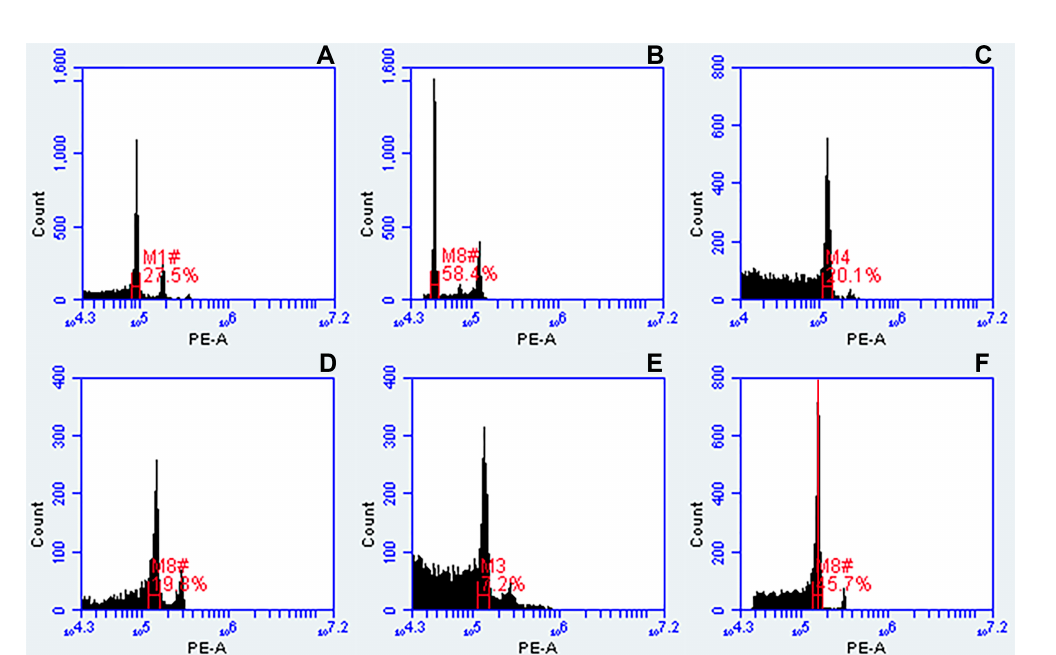
Figure 2. Optimization of flow cytometry assay for dried leaf samples. ( A ) Three gradually declined peaks of diploid U. decumbens CIAT 26185 indicating endoreduplication; ( B ) additional high peak in histogram of tetraploid U. maxima CIAT 16055, indicating contamination of leaf sample; ( C ) fresh and ( D ) dried leaf samples of Panicum miliaceum showing the same position of peaks in histograms, but slight differences in number of nuclei and CV of DNA peaks; ( E ) histogram of dried leaf sample of Panicum miliaceum with no gating tools applied; ( F ) histogram of dried leaf sample of Panicum miliaceum where gating tools were applied, giving sharp peaks and low background. Here, gain or peak height was adjusted using a software function (VirtualGain) and the center of the peak selected as reference point (red line; Peak Definition Marker). Regions of identification (red marks) were placed across the peaks to export fluorescence values representing peak positions and CVs (coefficient of variation of G0/G1 peaks).